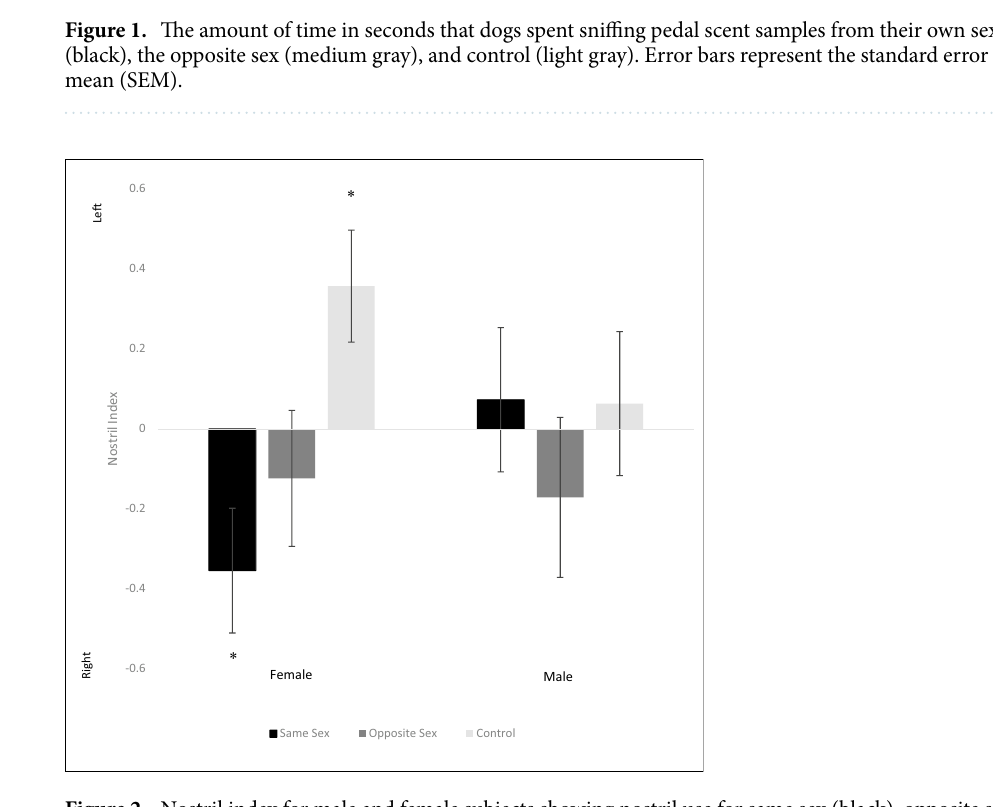
Figure 2. Nostril index for male and female subjects showing nostril use for same sex (black), opposite sex (medium gray), and control (light gray) with error bars representing the standard error of the mean (SEM). A negative index indicates predominant use of the right nostril, which is associated with arousal, while a positive index indicates use of the left nostril, or a more calming or neutral stimulus. Asterisks indicate a significant deviation from zero ( P < 0.05, two-tailed one-sample Wilcoxon signed rank